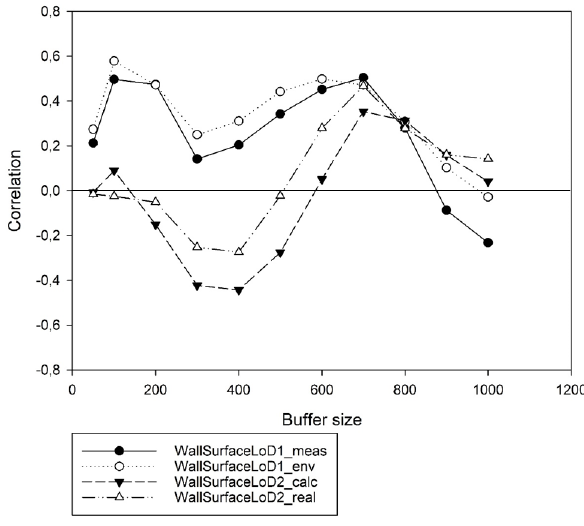
Figure 13. Correlation coefficient of different wall surface calculations with the measured TNC values in different buffer